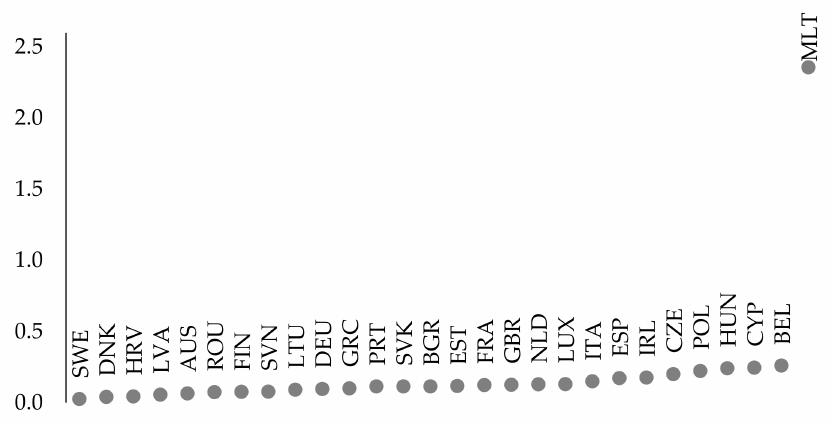
Figure A4. Linear ordering of the EU countries on the basis of the random variation coefficient determined on the basis of exponential